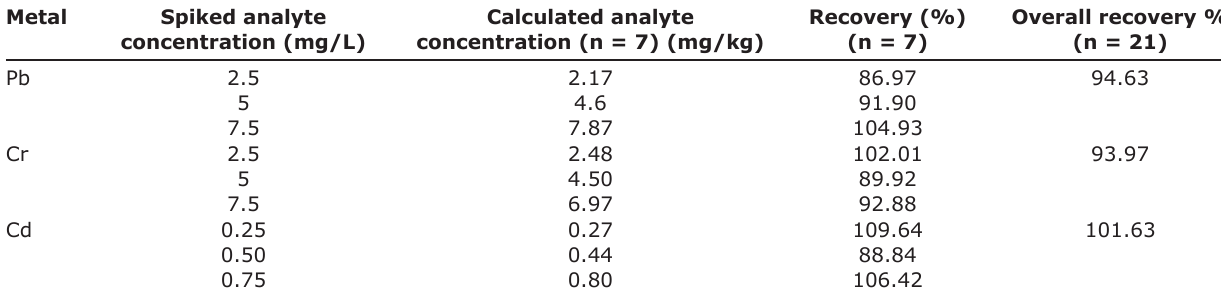
Table-3: The recovery (%) of heavy metals in poultry feed. Metal